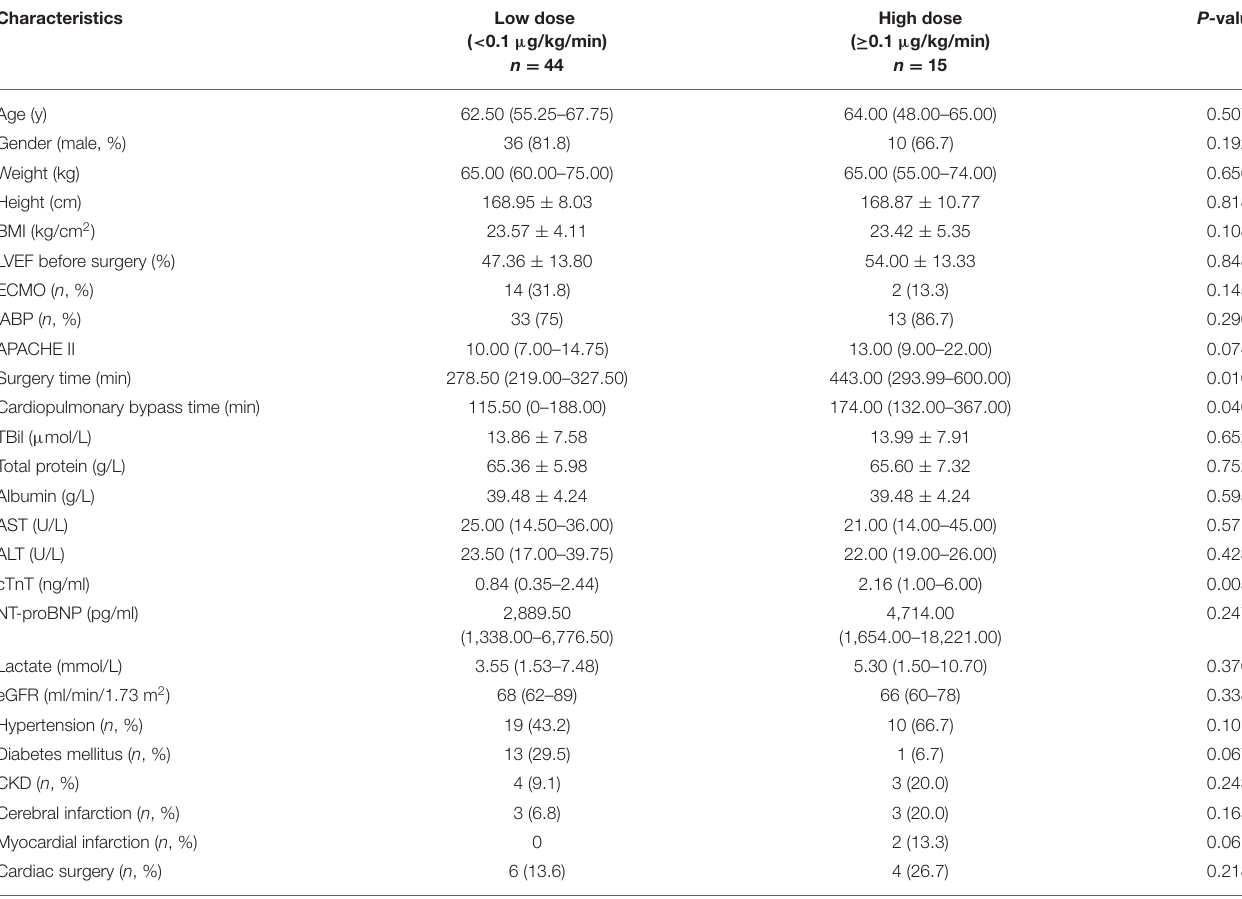
TABLE 5 | Patient baseline characteristics, grouped by the dose of norepinephrine equivalents.